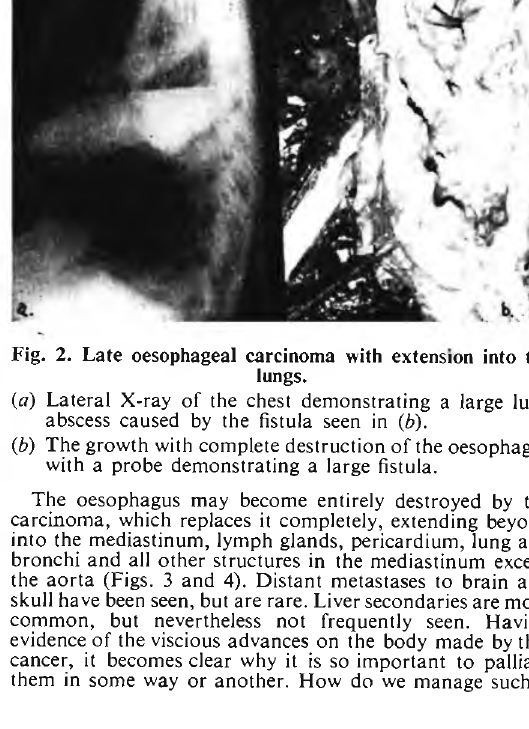
Fig. 2. Late oesophageal carcinoma with extension into the lungs. (a) Lateral X-ray of the chest demonstrating a large lung abscess caused by the fistula seen in ( b ). (b) The growth with complete destruction of the oesophagus with a probe demonstrating a large